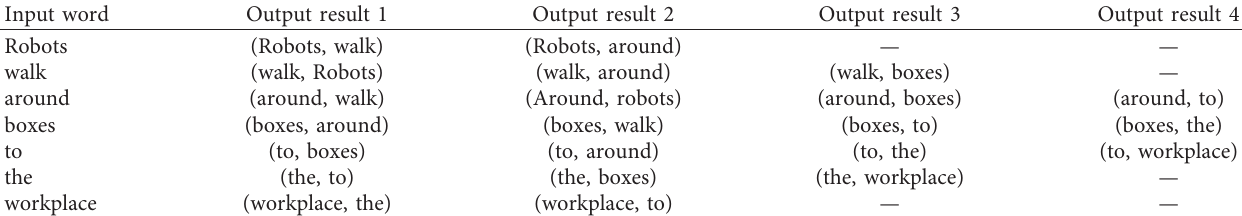
Table 1: Training samples based on Skip-gram algorithm.